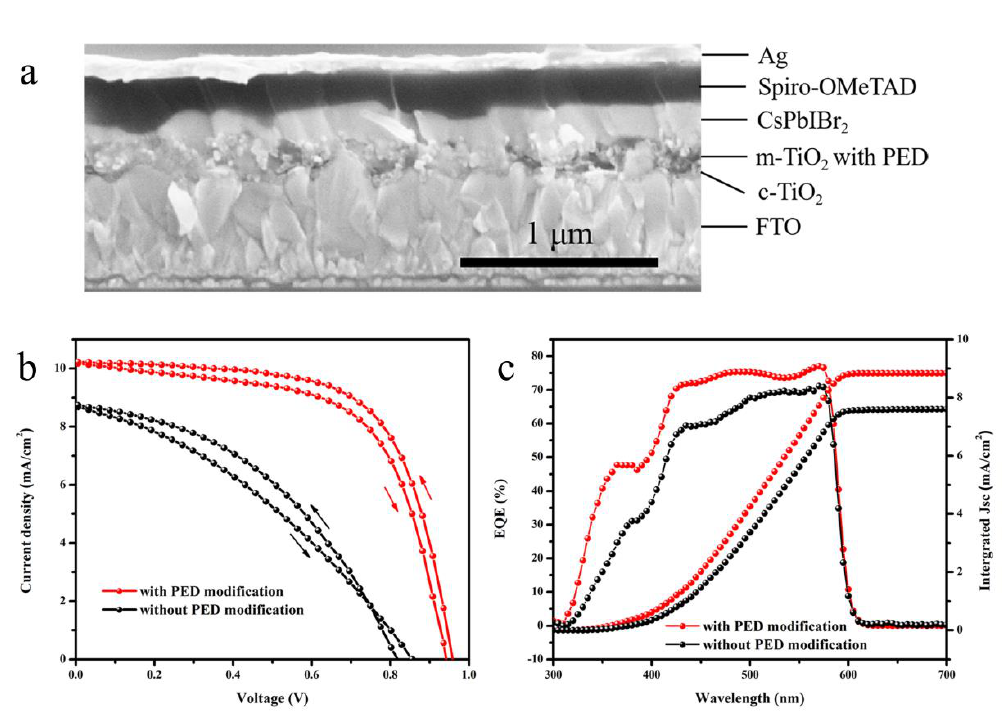
Figure 5. ( a ) Cross-sectional SEM image of the modified CsPbIBr 2 devices. ( b ) J-V curves and ( c ) EQE spectra and the integrated product of the EQE curve of the corresponding devices. Table 1. Photovoltaic parameters of the CsPbIBr 2 devices with and without PED modification.